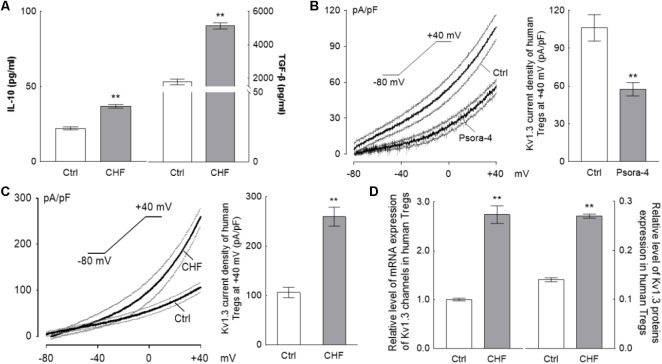
The changing of Tregs activation for CHF patients. (A) The histograms differences of serum IL-10 and TGF-β between the CHF patients and the control persons by ELISA assay. Levels of both IL-10 and TGF-β were elevated significantly in the CHF group compared to the blank control group, nevertheless, the elevation of IL-10 (65.9%) was far less than that of TGF-β (2.9-fold) (∗∗P < 0.01, n = 30 vs. 30). (B) The Kv1.3 channels on the Tregs membrane were identified by perfusion with 3 nM Psora-4 (a specific Kv1.3 channels inhibitor) under voltage ramp from –80 mV to +40 mV of 300 ms duration (n = 15, the black traces are averaged dots of all the recording cells and the gray lines are standard error dots of them); the histogram on the right of B is the Kv1.3 current density at +40 mV spot. (C) Recording at same protocol on the Treg cells of CHF patients, the elevation of the current density (∼2.5-fold of the healthy volunteers, n = 22 vs. 20, ∗∗P < 0.01) was obtained at +40 mV of voltage clamp. (D) Relative level of mRNA and protein expressions of Kv1.3 channels of Tregs of the CHF patients were also elevated significantly compared to the control (n = 10 vs. 3 for mRNA and n = 6 vs. 6 for protein, ∗∗P < 0.01). All the above graphs elucidated that during the CHF states, Tregs were activated and secreted cytokines, i.e., IL-10 and TGF-β, though the proliferation of Tregs was suppressed significantly (according to the results of Figure 1).